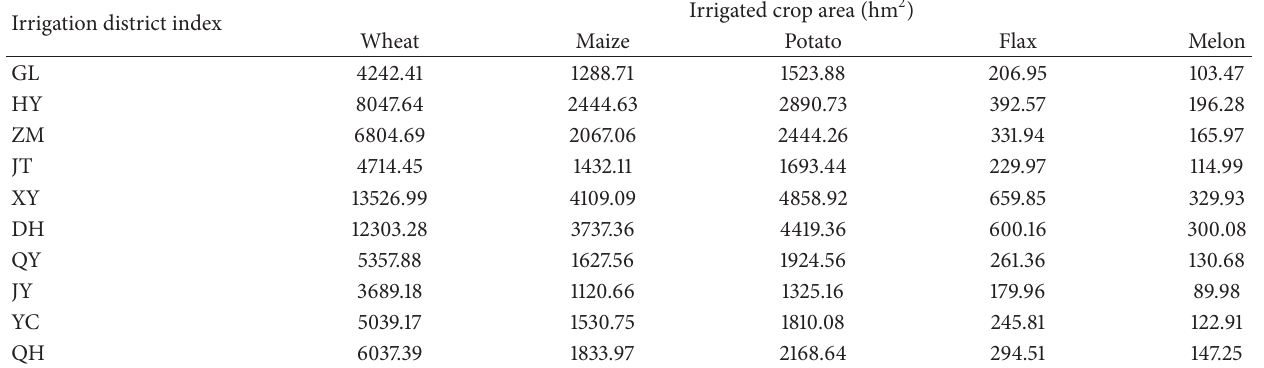
Table 2: The irrigated crop area of each irrigation